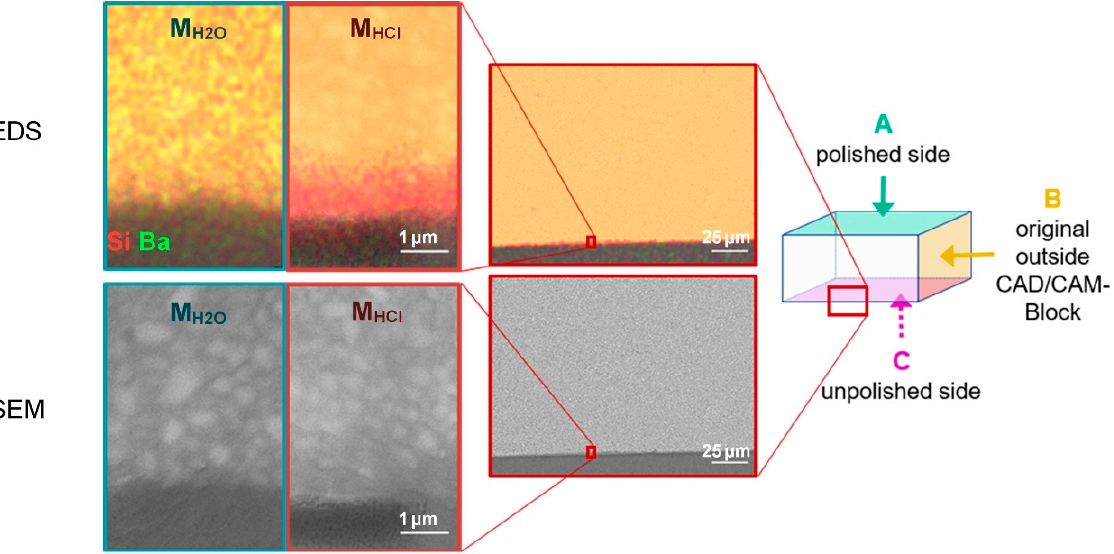
Figure 4. Visualization of the investigated C E cross section. SEM images (bottom) and EDS mapping (top; Si, Ba) at the edge of the unpolished side C. Images of samples stressed in M HCl with a red frame (and in M H2O with a blue frame for comparison). Note that yellow areas result from an overlay of red Si and green Ba.